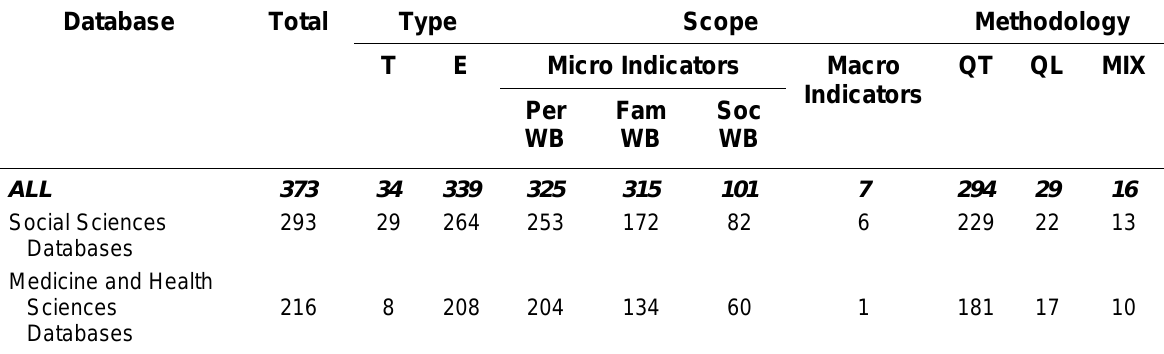
Classification of Studies about the QOL in Hong Kong in Three Dimensions (Type, Scope, and Methodology) According to Two Broad Categories of Databases (Social Sciences Databases and